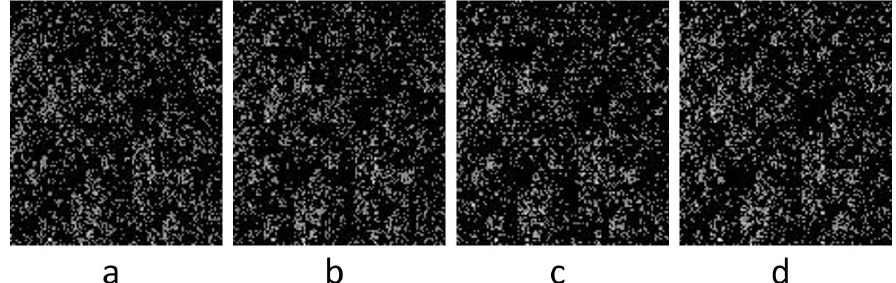
Figure 3. Examples of CGR images for a small section from Kate Atkinson, “Life After Life” ( a ), Margaret Atwood, “Dancing Girls and other stories” ( b ), Neil Gaiman, “Neverwhere” ( c ) and P. D. James: “The Lighthouse” ( d ).